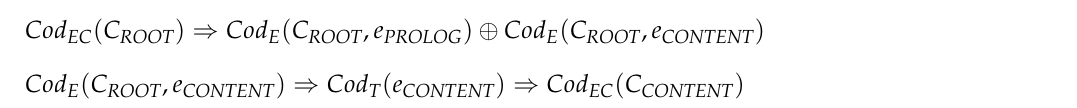
Figure 7. Schema example instance.